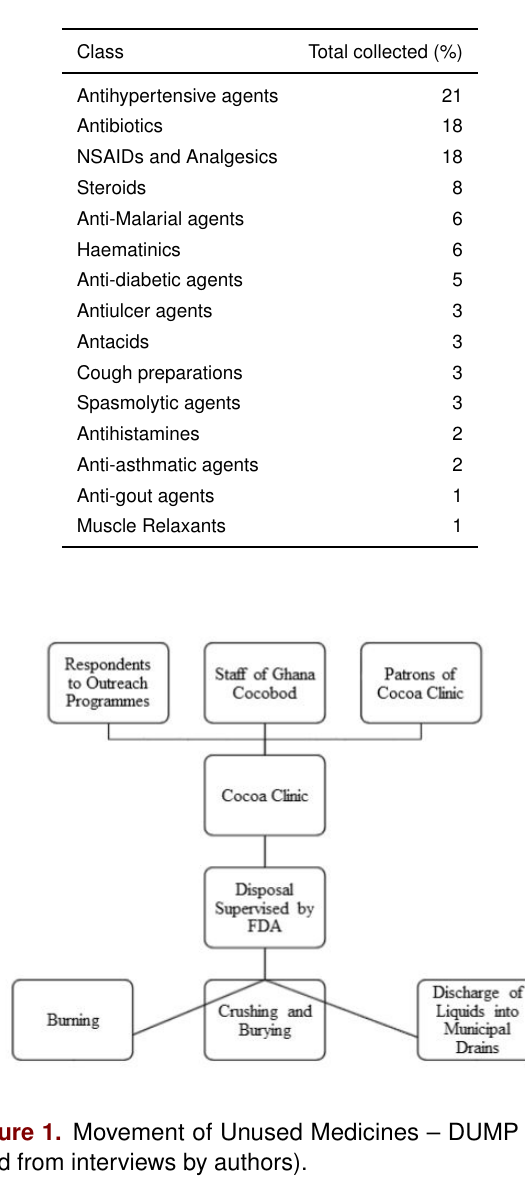
Table 1. Categories and Quantities of Medicines Received for Disposal under DUMP (Culled from Safe Medicines, 2011).